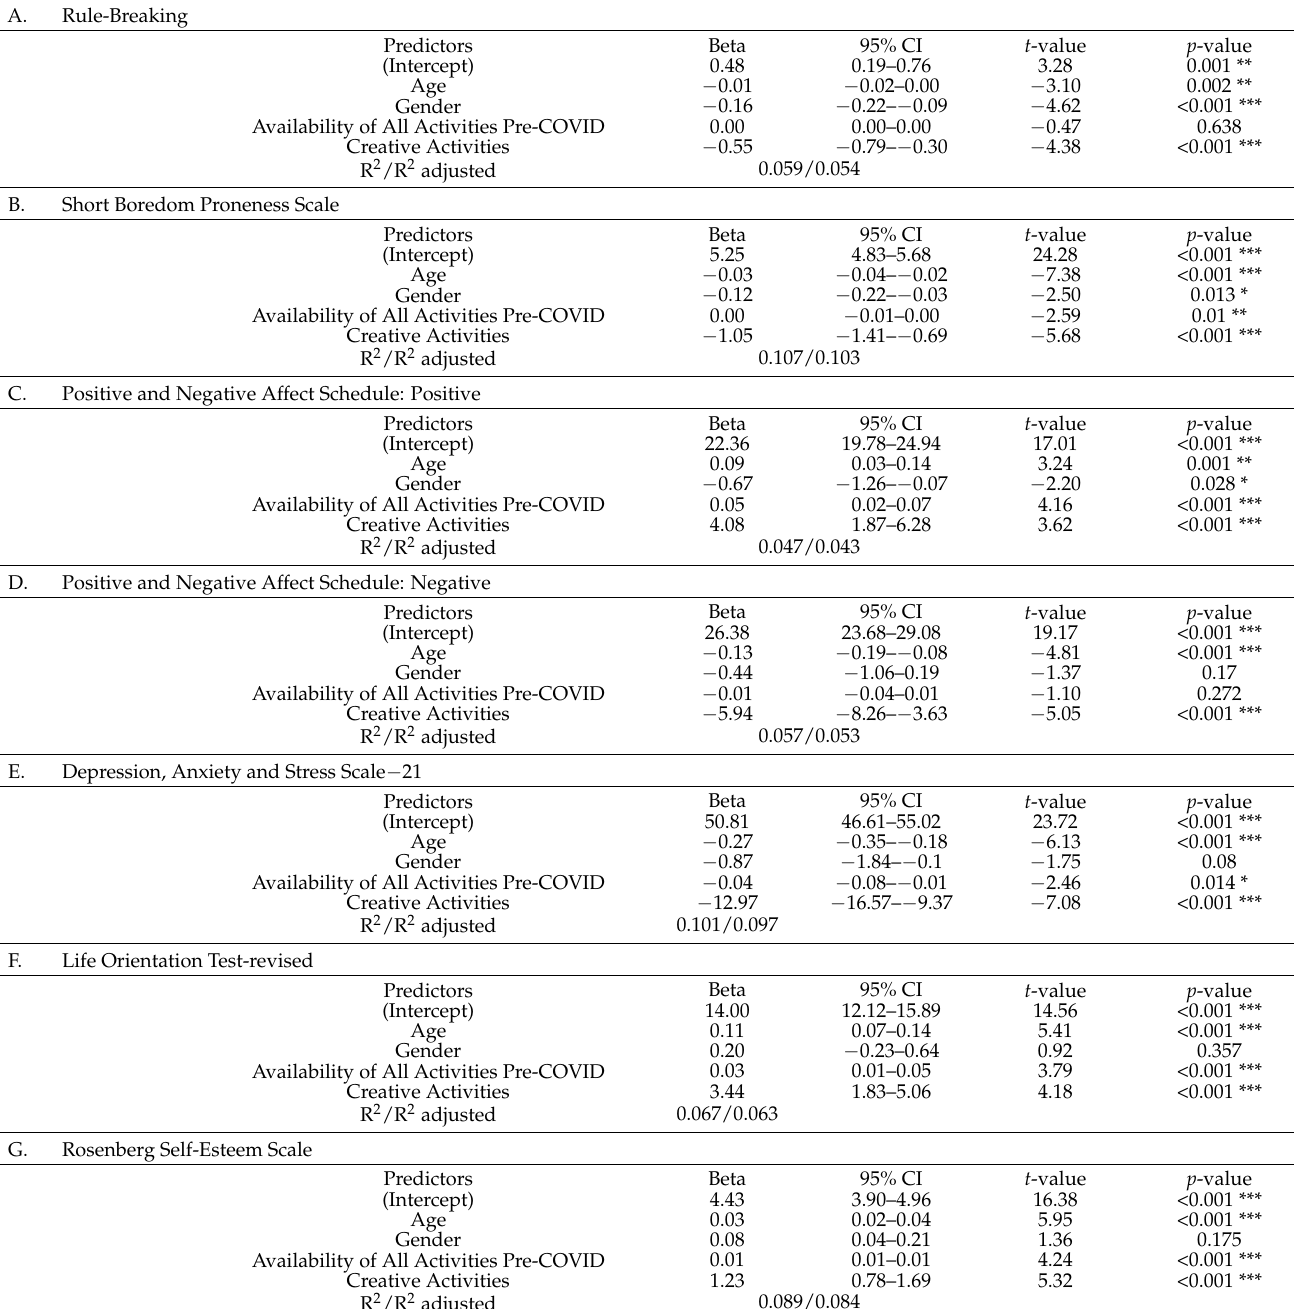
Table 3. Regression models predicting